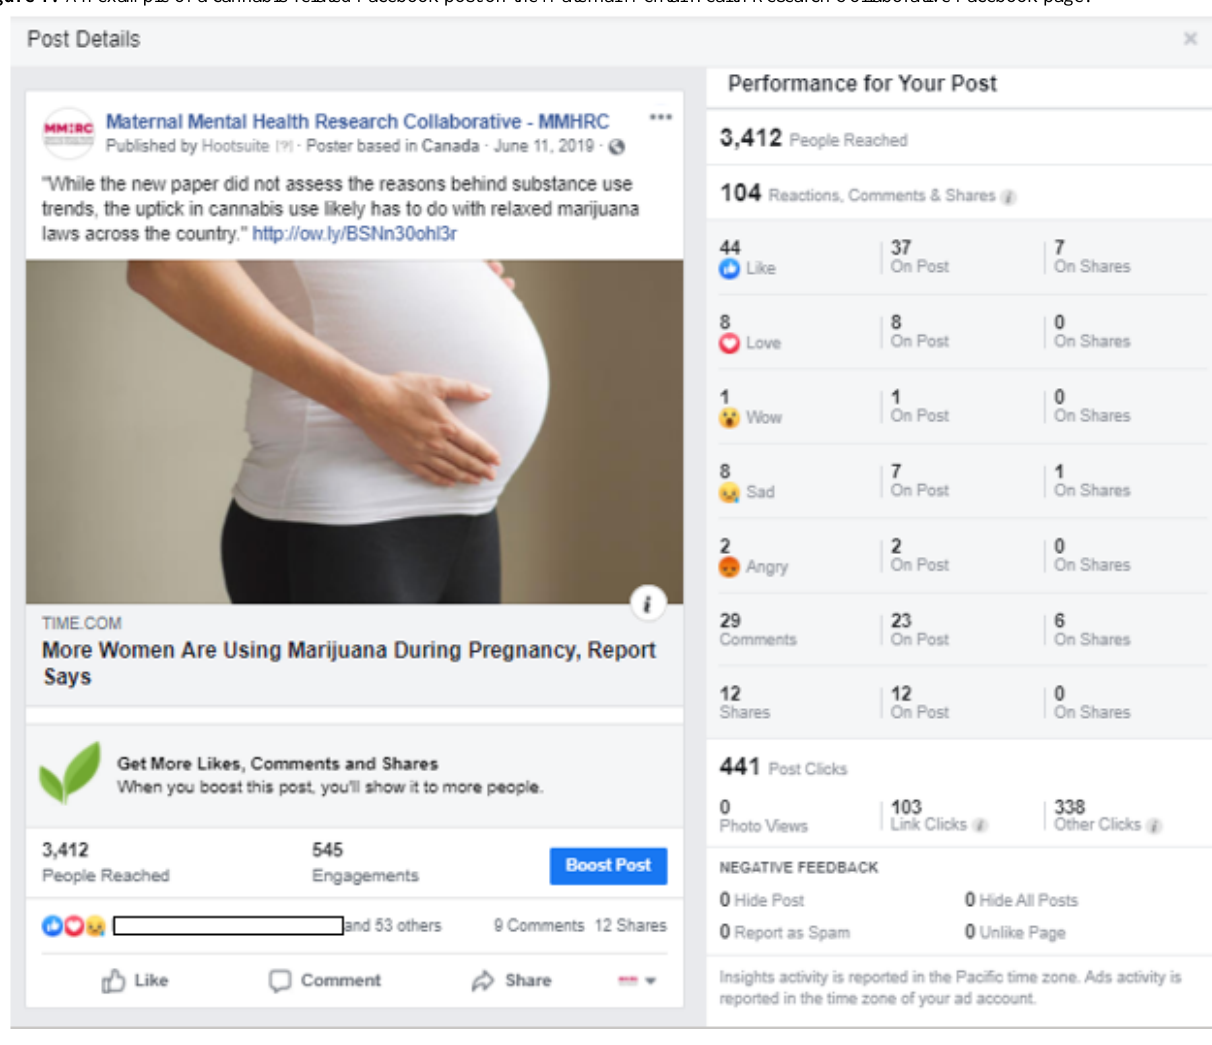
JMIR Form Res 2021 | vol. 5 | iss. 6 | e24353 | p. 2https://formative.jmir.org/2021/6/e24353/ (page number not for citation